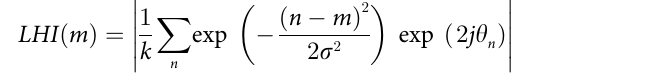
ffiffiffiffiffiffiffi p (cid:0) 1 and | | represents